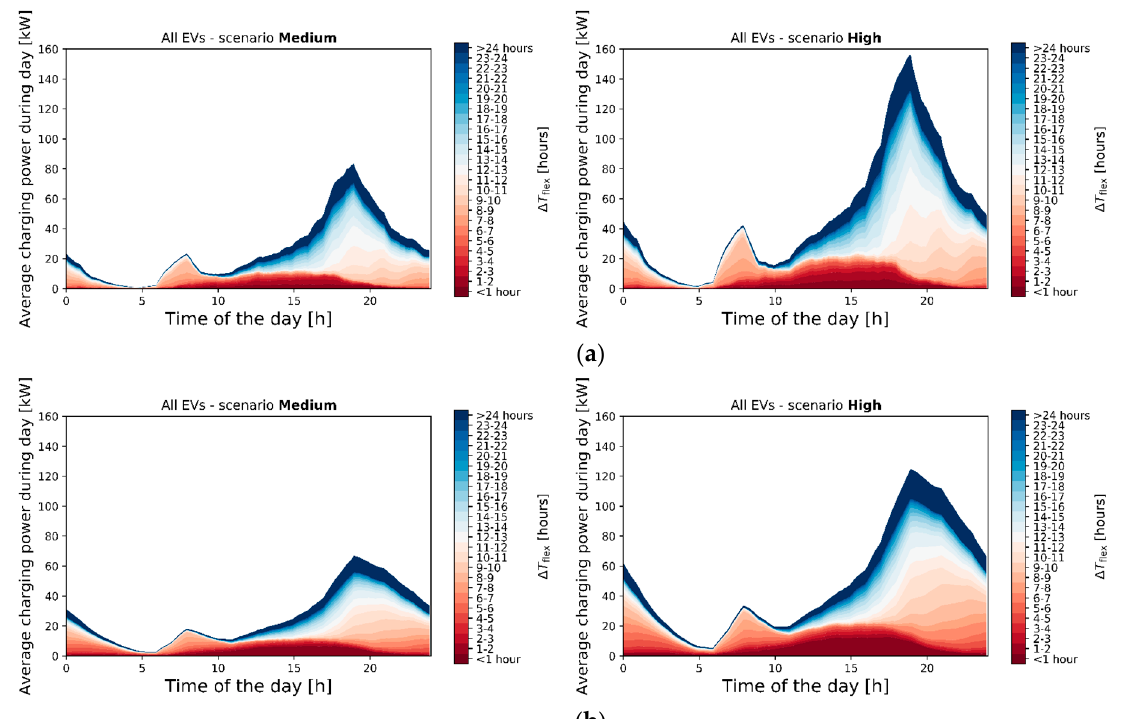
Figure 8. ( a ) Presentation of the simulated time-dependent flexibility, averaged over the day over all 50 simulation runs, for ‘Medium’ ( left ) and ‘High’ ( right ) scenarios, using P fixed (22 kW for BEVs and 3.7 kW for PHEVs). ( b ) Presentation of the simulated time-dependent flexibility, averaged over the day over all 50 simulation runs, for ‘Medium’ and ‘High’ scenarios, using P i av (see Equation